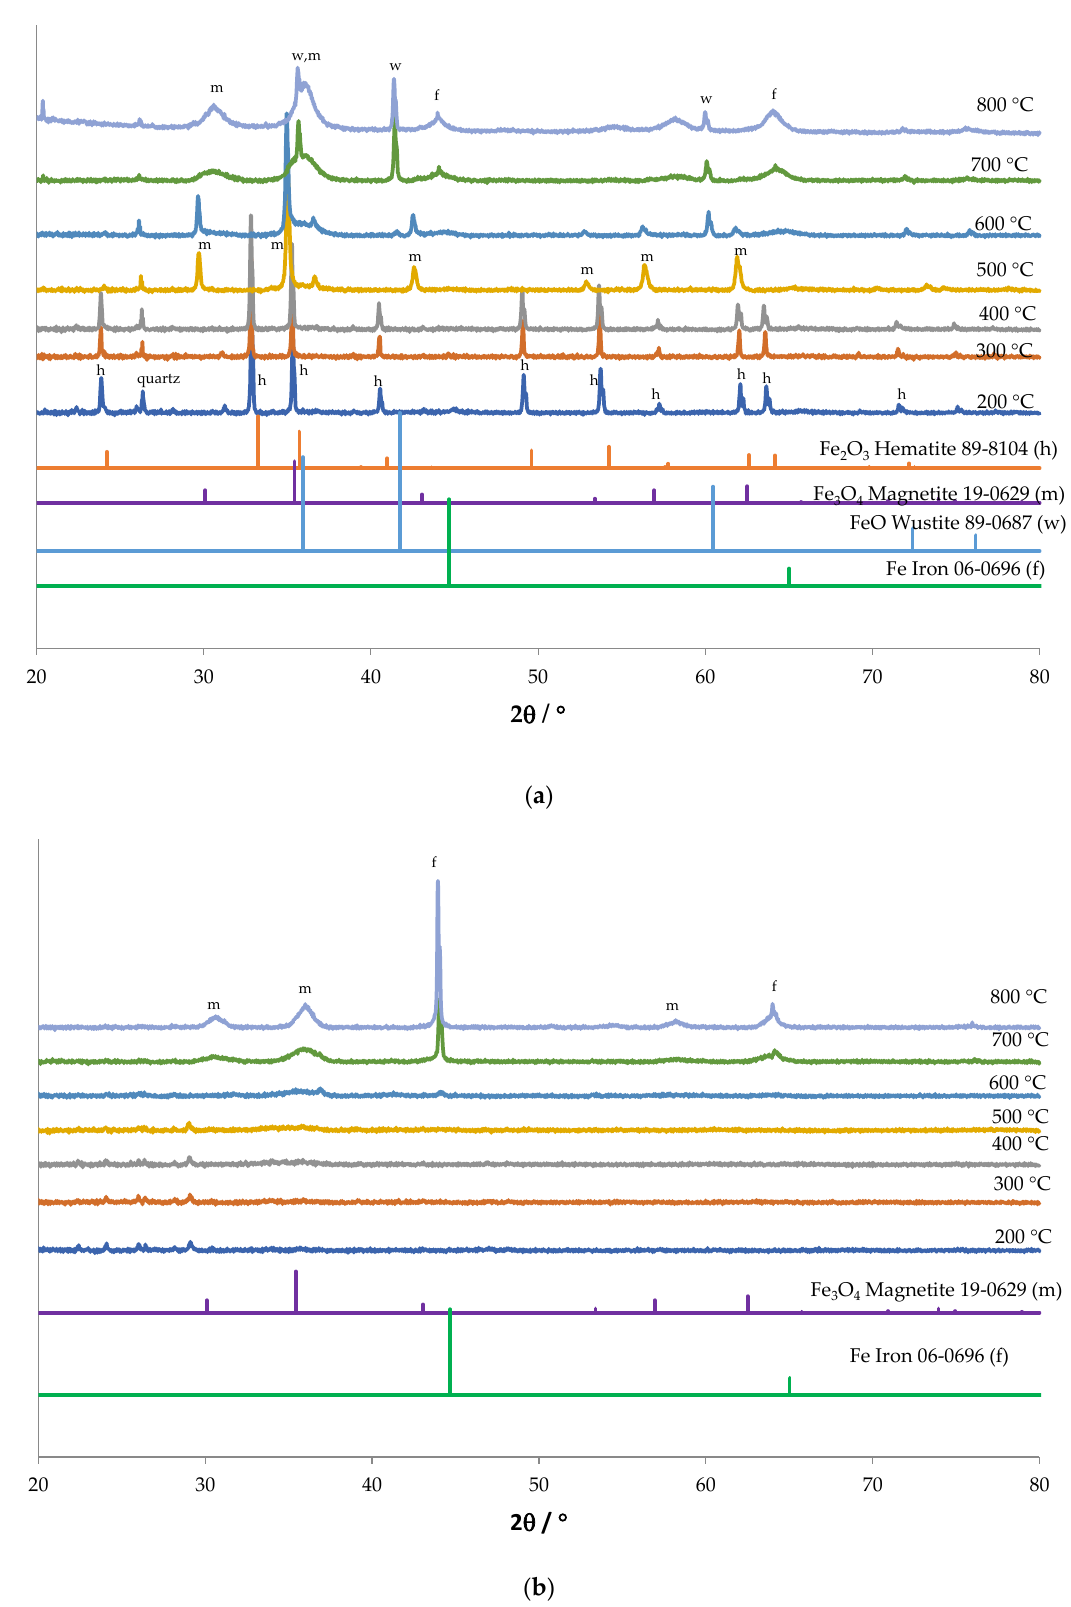
Figure 11. High temperature X-ray diffraction profiles of ( a ) RMP1-500 and ( b ) RMP2-500 pattern under reducing atmosphere (3% H 2 in N 2 ).